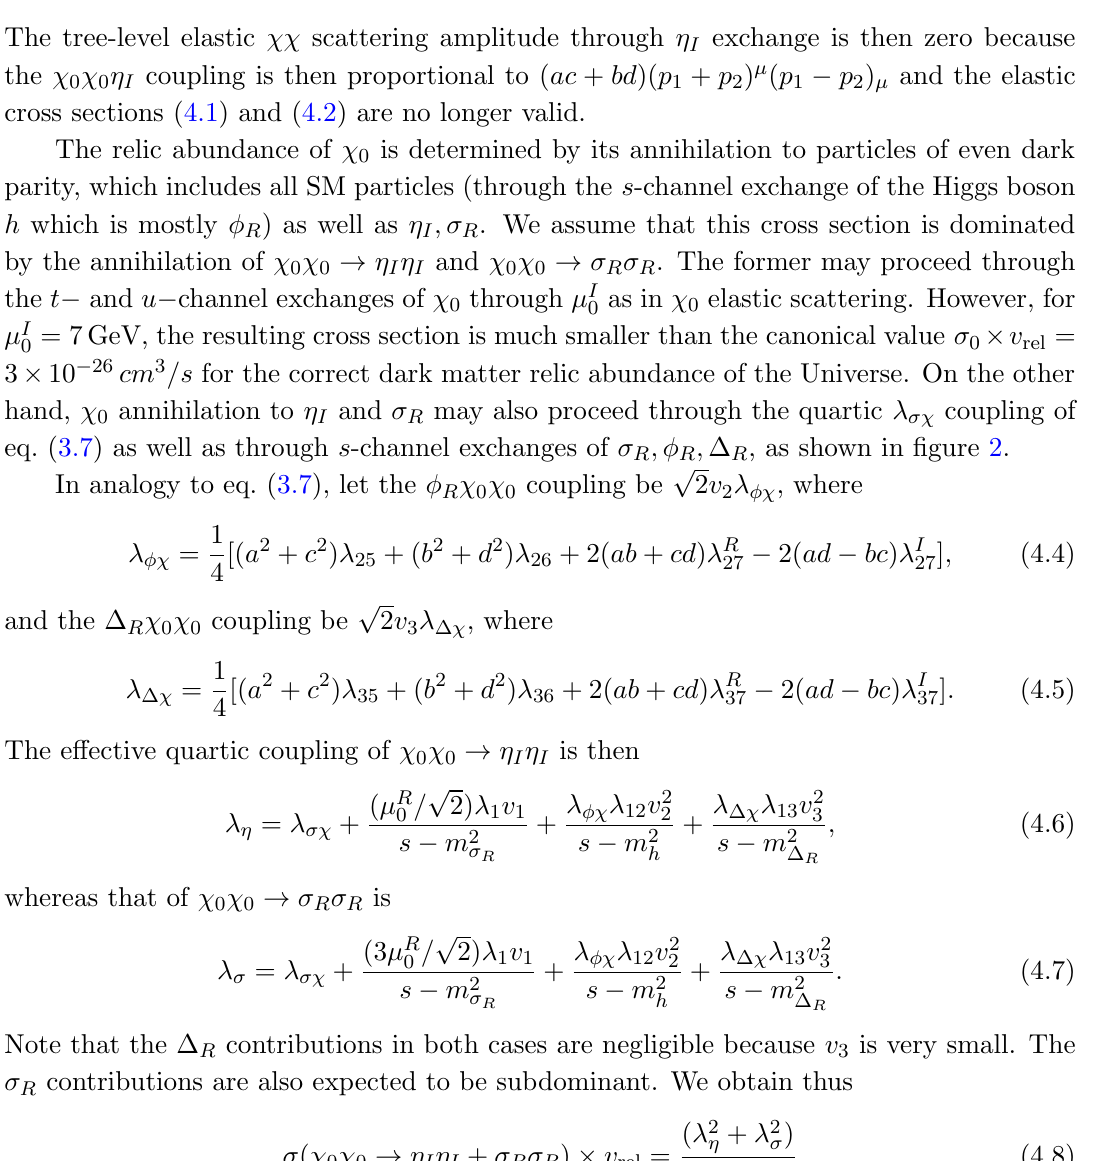
Figure 2 . Dark matter (cid:31) 0 (cid:31) 0 annihilation to (cid:17) I (cid:17) I + (cid:27) R (cid:27) R